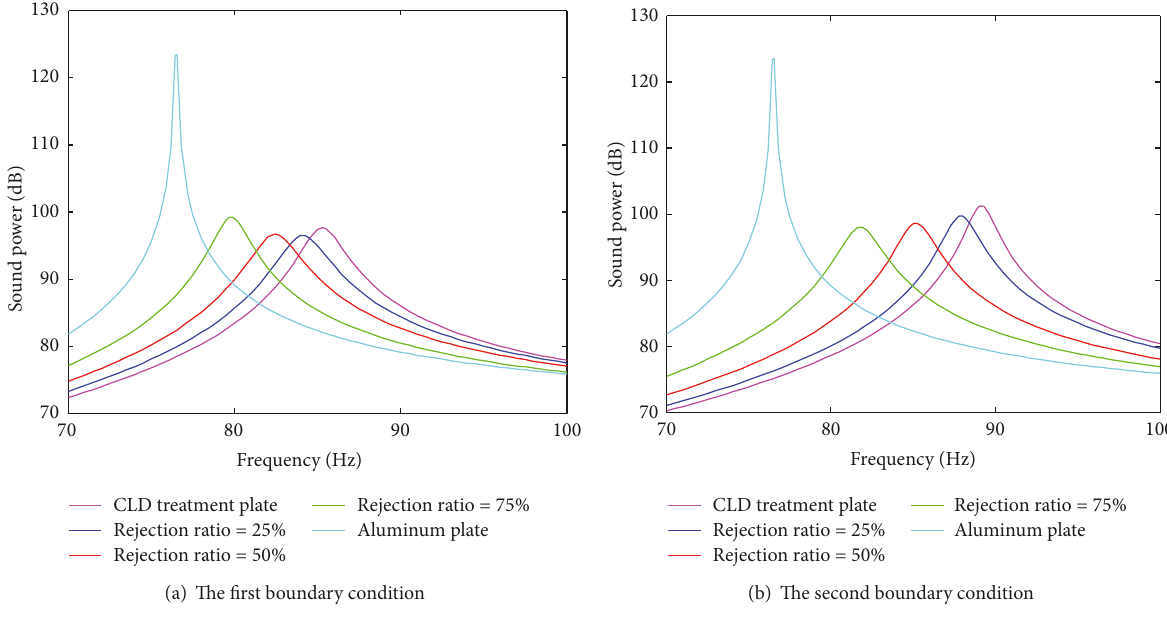
Figure 9: Frequency responses of sound power obtained using ESO under various rejection